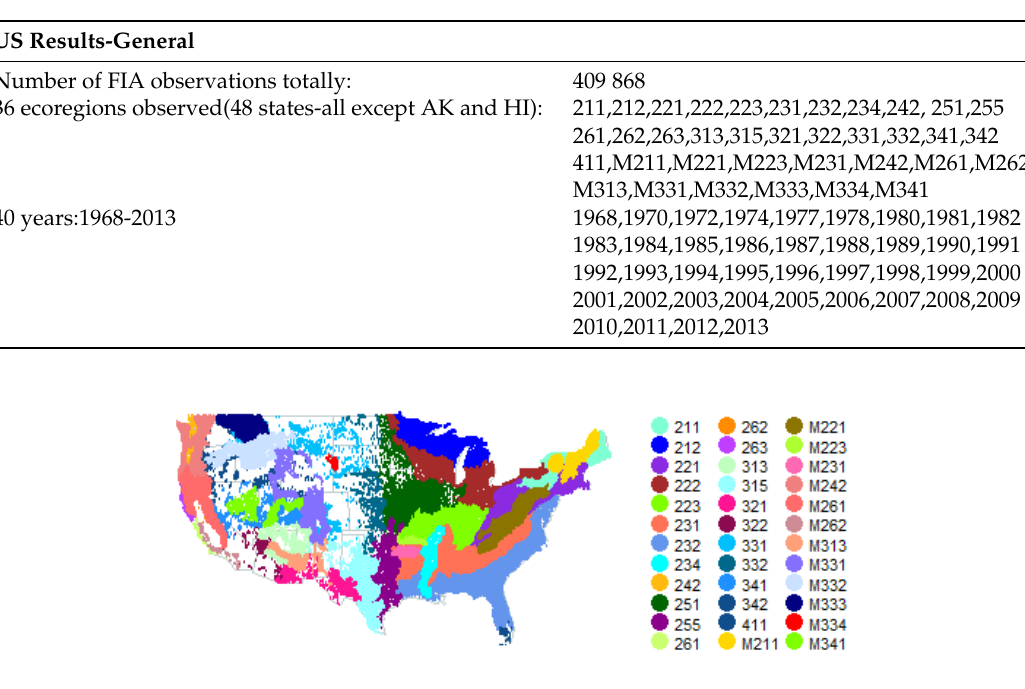
Figure 1. USA forest plots belonging to various ecological